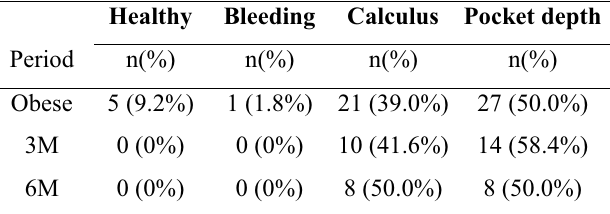
TABLE 2 - Distribution of patients according to CPI index